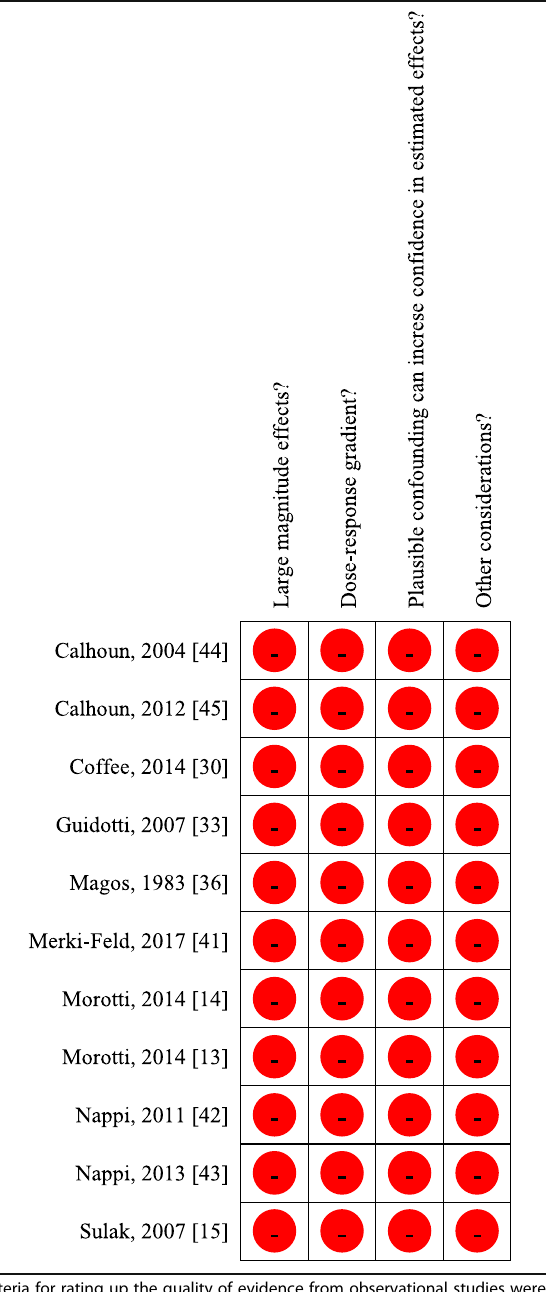
Table 3. The quality of evidence was rated as low for all Table 4 Assessment for rating up the quality of evidence for